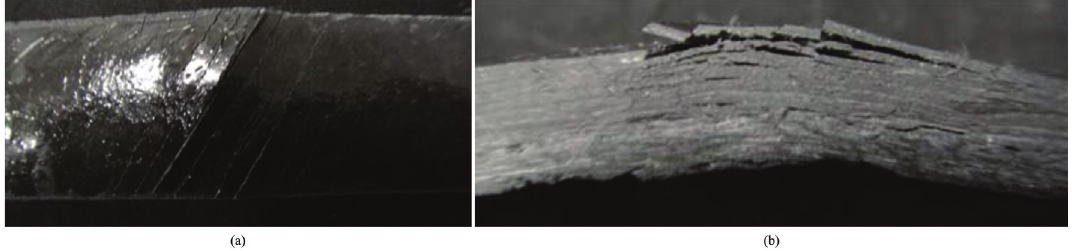
Figure 6. Macroscopic aspect of the failure of the three-point bending specimens. The crack started from the tensile stressed surface. a) Bottom view; b) Side